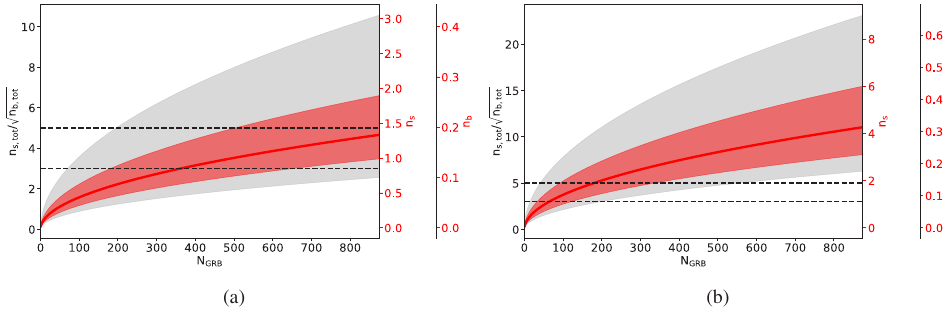
Figure 2: Level of significance n s , tot / √ n b , tot for (a) KM3NeT / ORCA + KM3NeT / ARCA and (b) Deep- Core + IceCube, achieved by stacking 900 LGRBs with Γ = 300, within the framework of the inelastic ∼ collisional model. The shaded red and gray regions indicate the uncertainty bands at 1 σ and 2 σ , re- spectively. The horizontal dashed black lines highlight σ tot = 3 and σ tot =